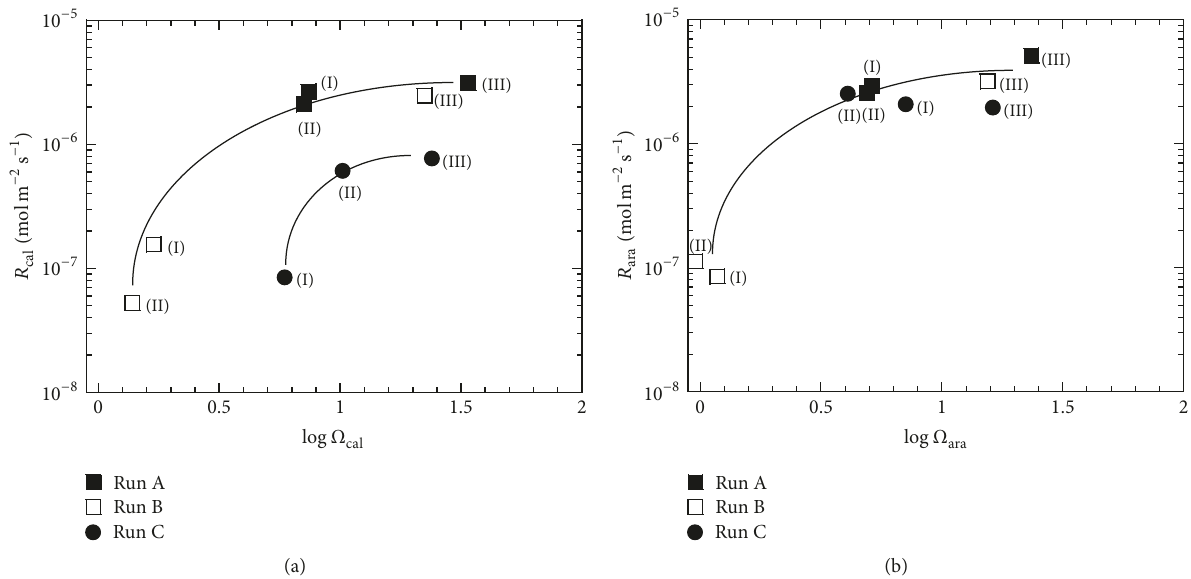
Figure 5: The log Ω dependence of R : (a) calcite and (b) aragonite. Roman numerals near respective dots denote measurement points. Each curve was drawn arbitrarily to clarify the trend of the relation between R and log Ω .